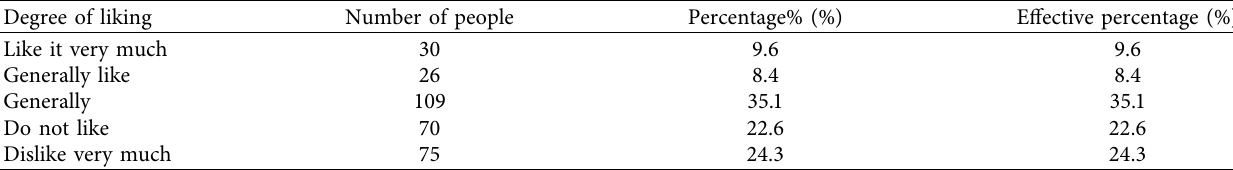
Table 4: Popularity of game A .